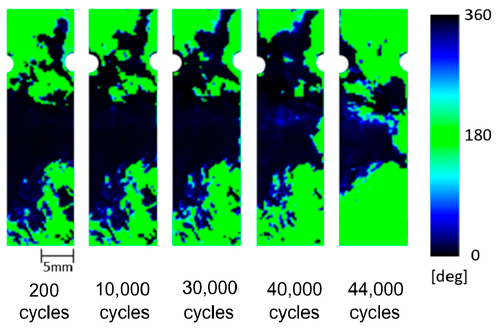
Figure 8. Distribution of phase delay measured at increasing loading cycles ( σ max = 180 MPa, f = 7 Hz).